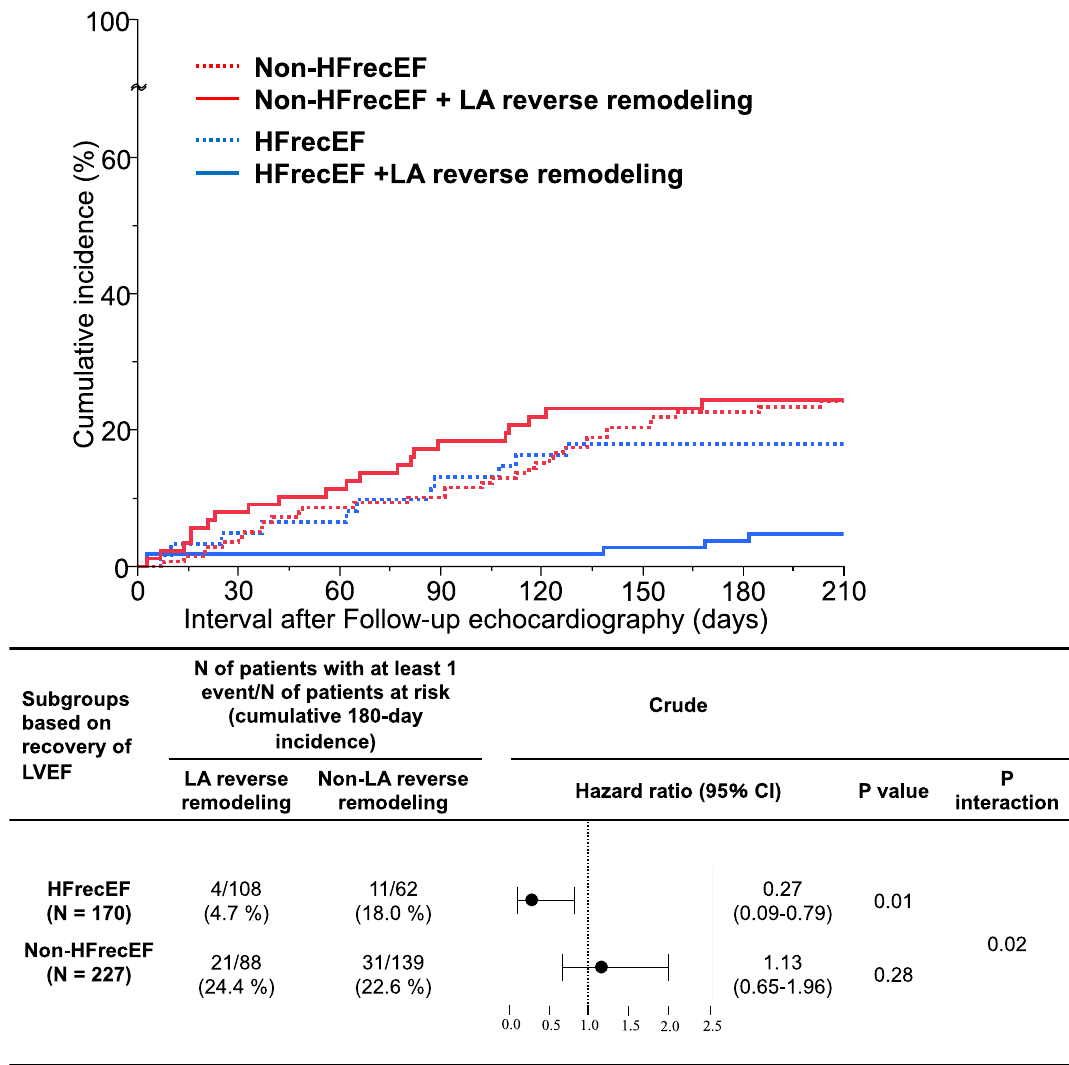
Figure 3. Analysis for a composite of all-cause death or hospitalization for heart failure by the combination of left ventricular and atrial reverse remodeling. Figure made utilizing JMP Pro 16.1.0, https:// www. jmp. com/ en_ us/ softw are/ predi ctive- analy tics- softw are. html. HFrecEF, heart failure with recovered ejection fraction; LVEF, left ventricular ejection fraction; LA, left atrium; CI, confidence